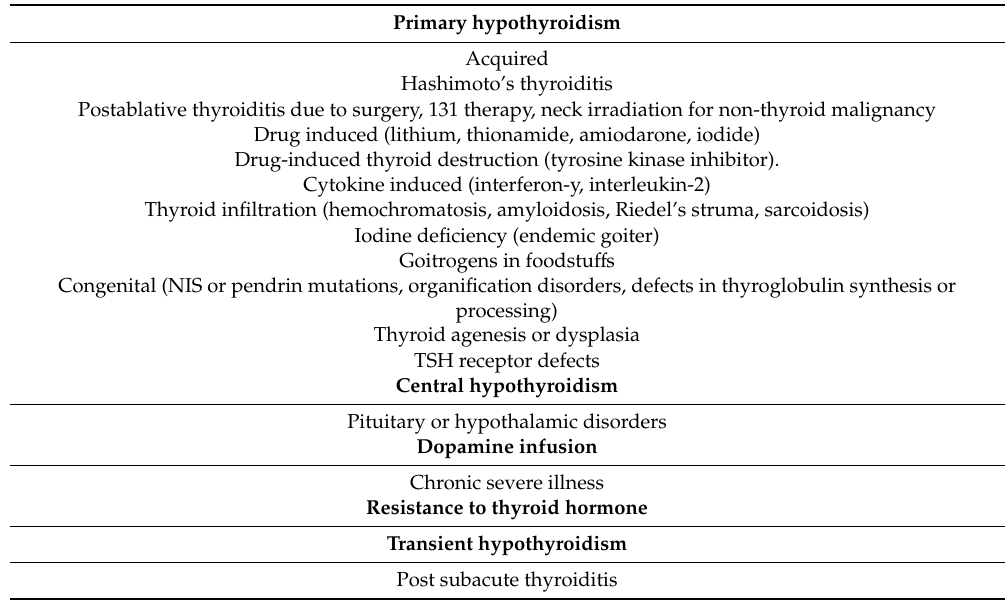
Table 4. Causes of